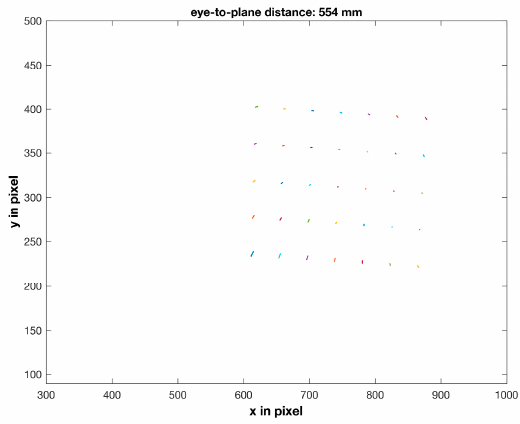
Figure A8. Map of disparities for a target plane placed at 554 mm from the observer.